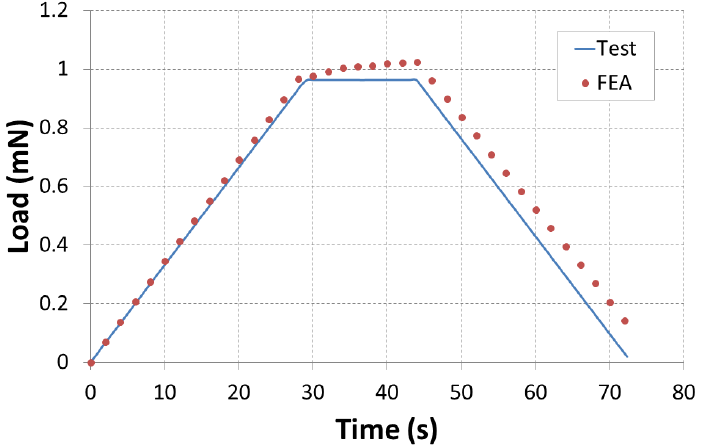
Figure 19. Correlation between the experimental and numerical load.